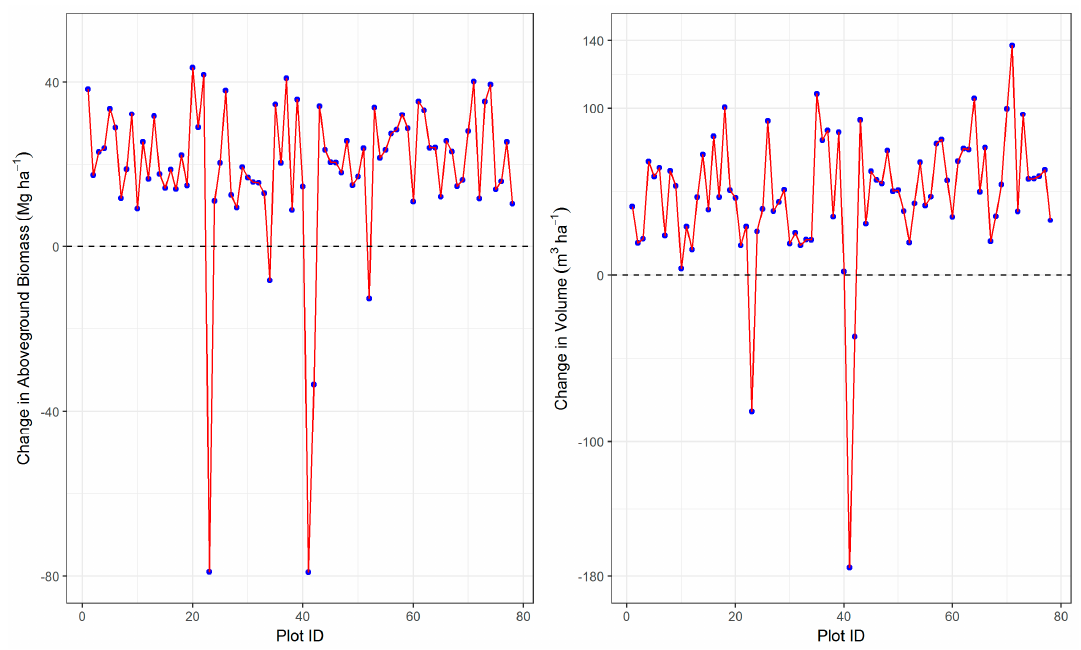
Figure 2. Change in biomass (Mg ha − 1 ) and volume (m 3 ha − 1 ) in different plots from year 2007 to 2012 based on repeated ground measurements.